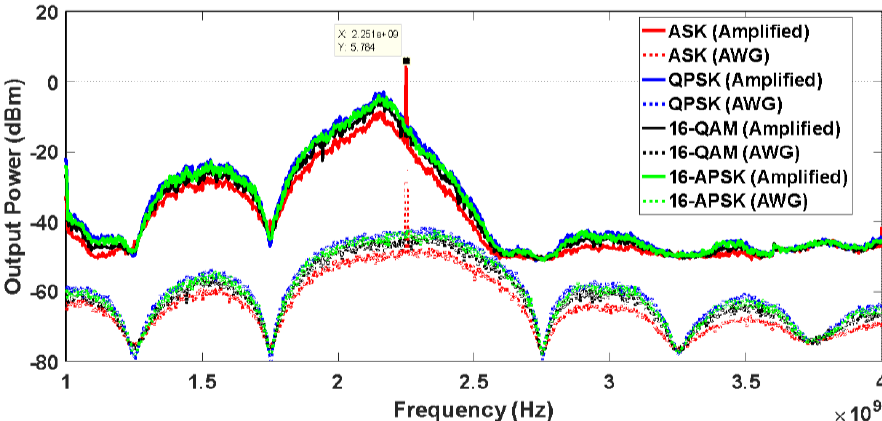
Figure 13. Performance of the signal condition chain with different modulations.